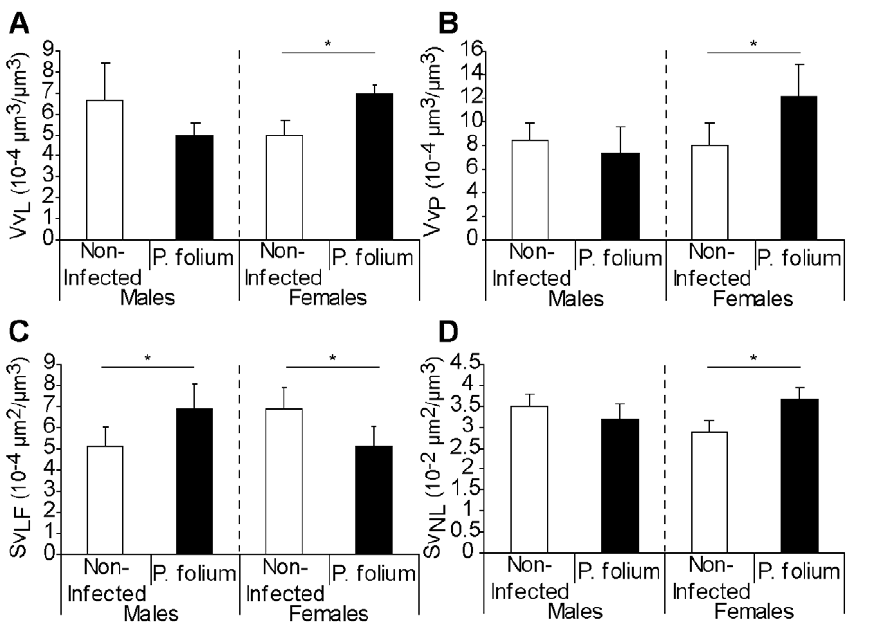
Figure 2. Cellular responses in the digestive gland of zebra mussels infected or not by P.folium . The four cellular responses measured in the digestive gland of zebra mussels, males and females, infected or not by P. folium (mean values 6 S.D.): ( A ) the structural changes of the lysosomal and ( B ) peroxisomal systems (volume densities), ( C ) the accumulation of lipofuscin granules and ( D ) neutral lipids (surface densities). The effect of infection was evaluated for each sex separately by a t-test and a significant difference was indicated by an asterisk (p ,